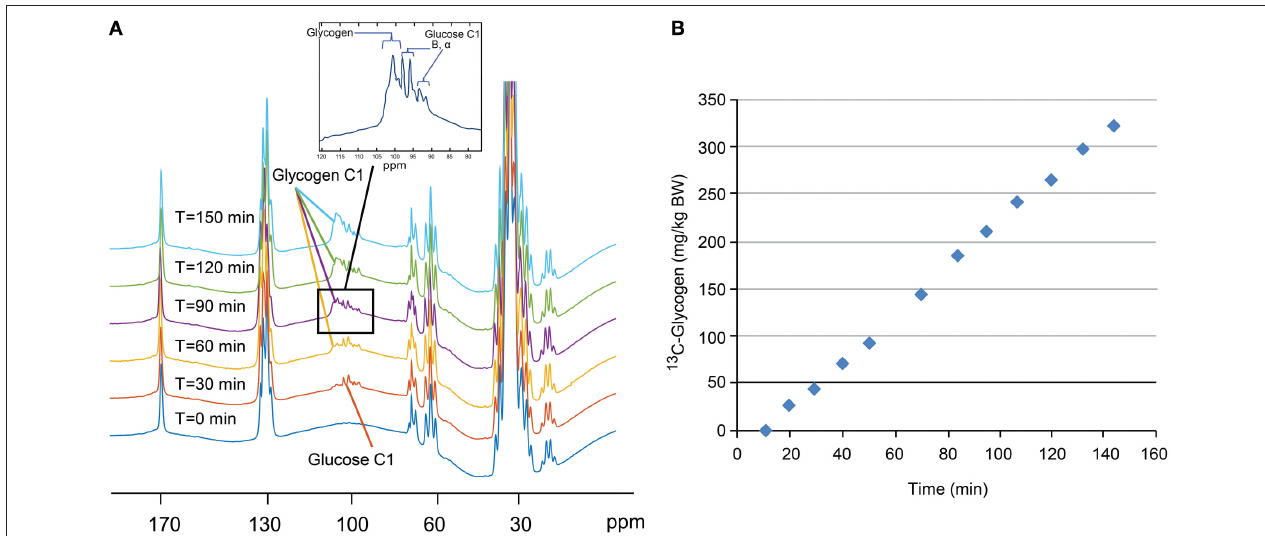
FIGURE 6 | Stacked plot (A) of 13 C NMR spectra from a sample single NHP study. Note the absence of 13 C-glycogen signal at T = 0 min and the increase over the next 2–3h. Time course (B) of the integral of the 13 C-glycogen signal for this single study showing a linear increase in